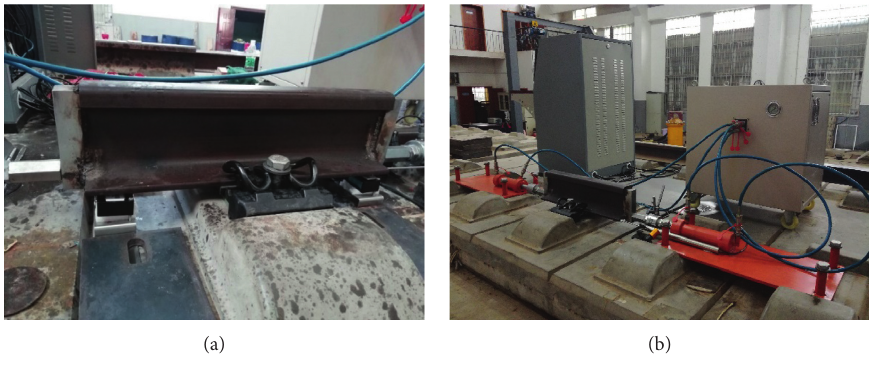
Figure 3: Diagram of the test device setup.